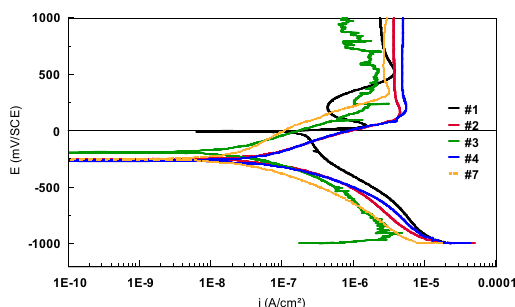
Figure 17. Potentiodynamic polarization curves recorded in artificial plasma bone for bulk Ti-based alloys (semi-logarithmic scale).